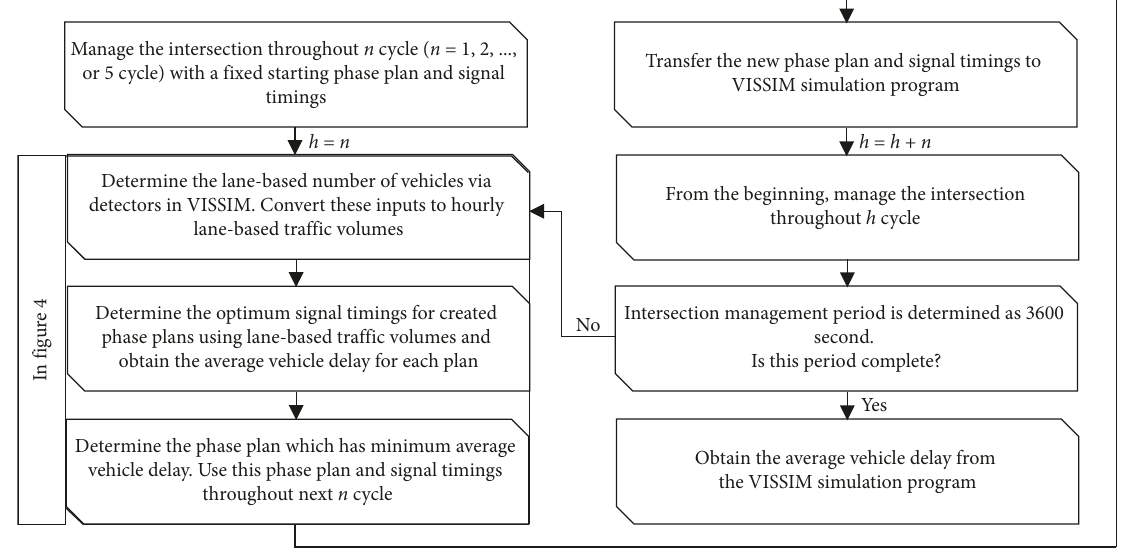
Figure 5: Flowchart of